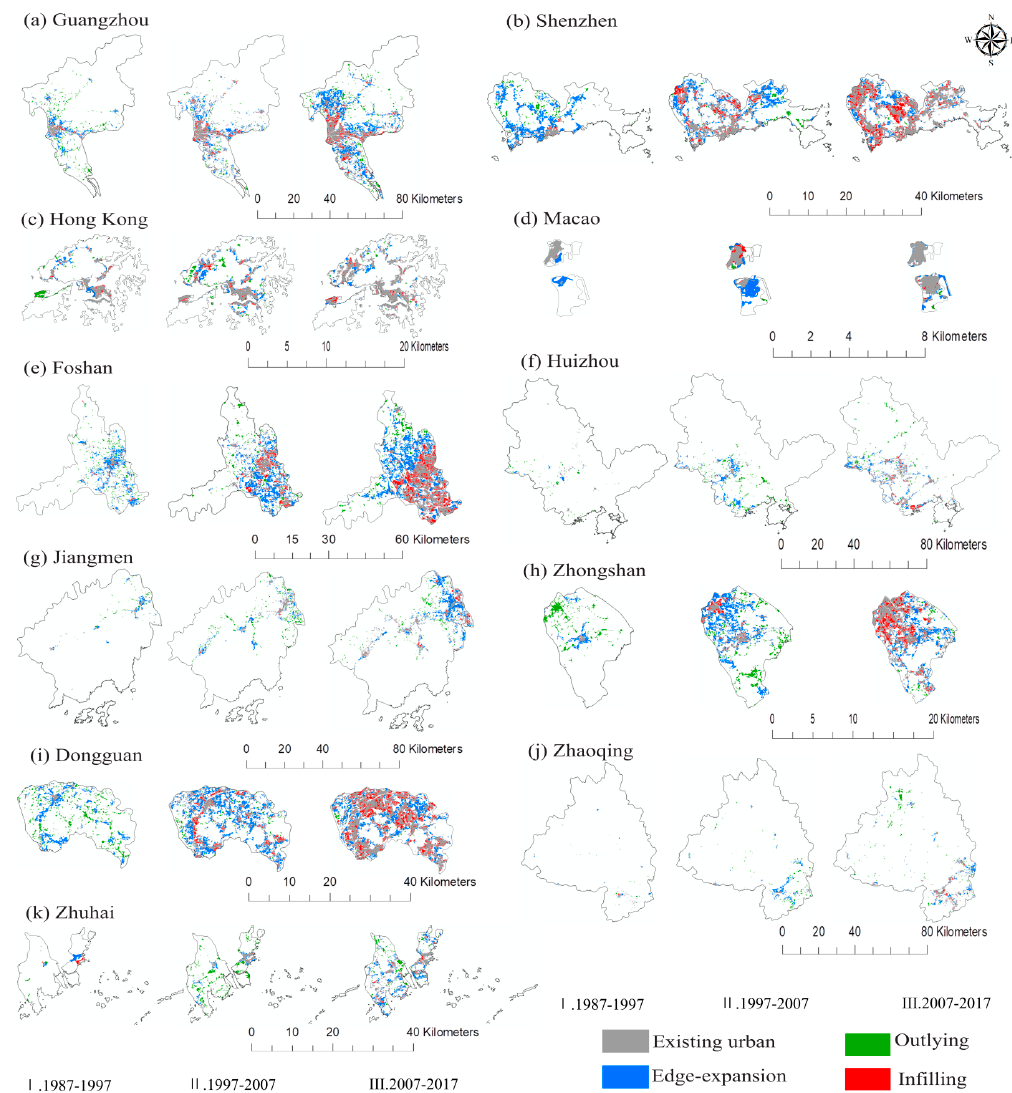
Figure 5. The spatial distribution of urban expansion types in all 11 cities in the GBA for three neighboring periods in 1987–2017.